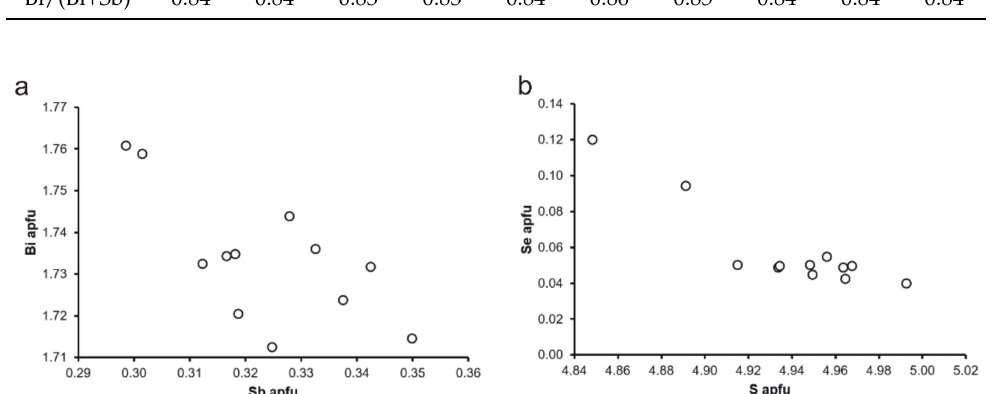
Figure 11. Interdependence of Sb vs. Bi ( a ) and S vs. Se ( b ) in cosalite from ˇCuˇcma (Majersk á